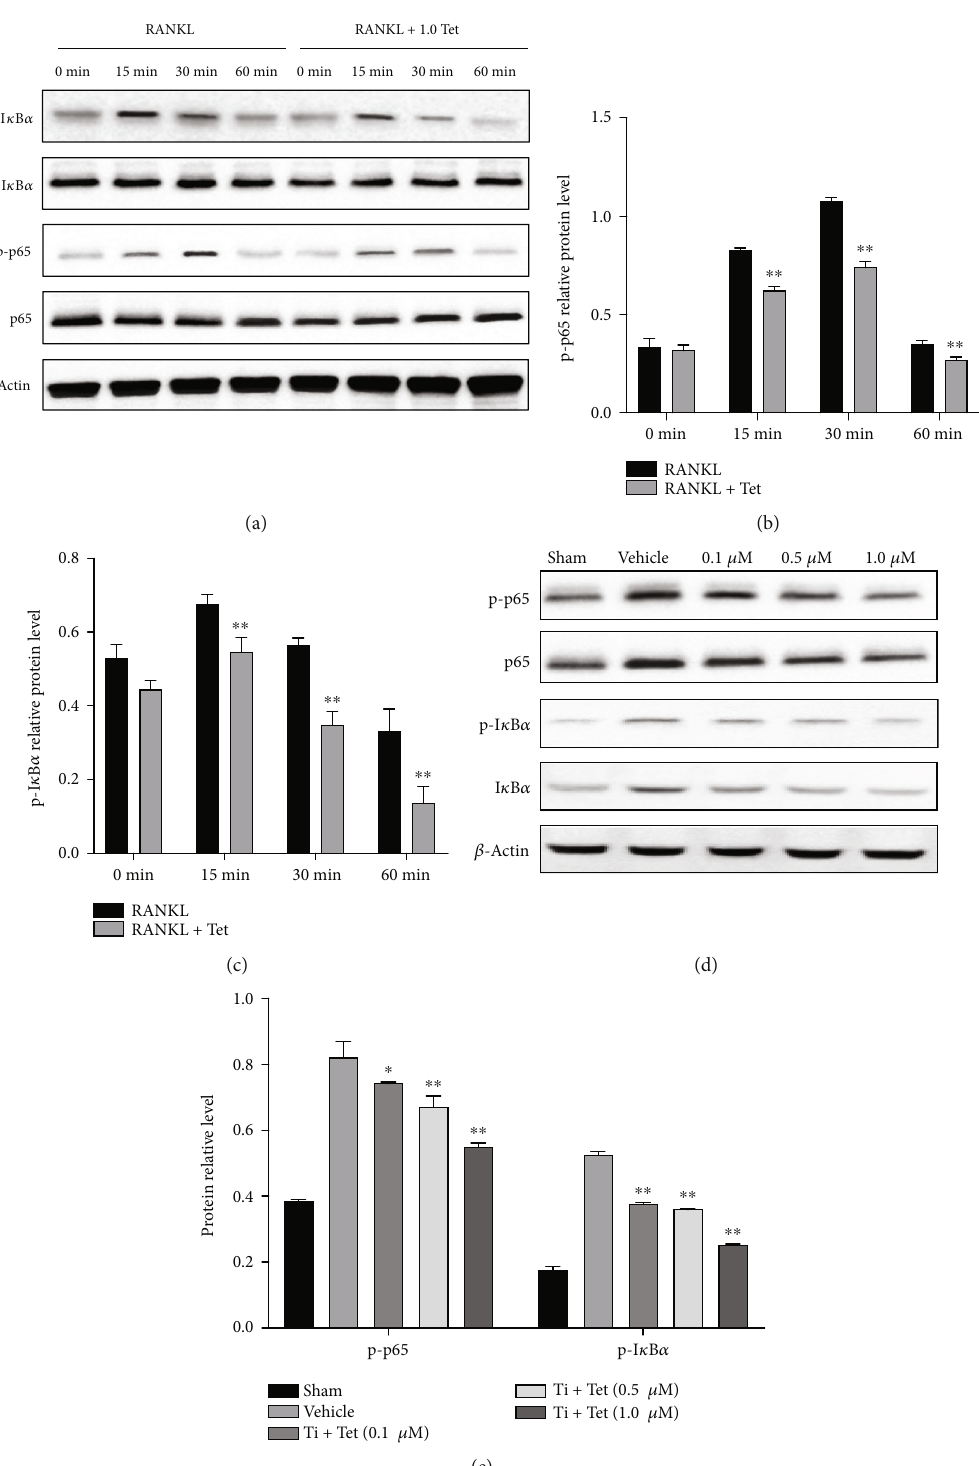
Figure 7: Tetrandrine (Tet) inhibits osteoclastogenesis through the nuclear factor (NF)- κ B signaling pathway. (a) Protein expression of the NF- κ B signaling pathway. (b, c) Gray band levels of the phosphorylated inhibitor of NF- κ B α (p-I κ B α ) (b) and phosphorylated p-65 (p-p65) (c) were analyzed using Image J software. (d) After 5 days of treatment with various Tet concentrations, the cells were lysed for Western blotting, and the gray band levels of p-p65 and I κ B α were analyzed using ImageJ software ( ∗ p < 0 : 05 , ∗∗ p < 0 : 01 compared with the vehicle group; n = 3 per group). Data are the means of at least three independent experiments with similar